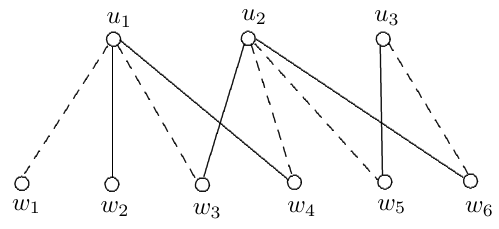
Figure 3: A subgraph H (cid:48) in H when s =